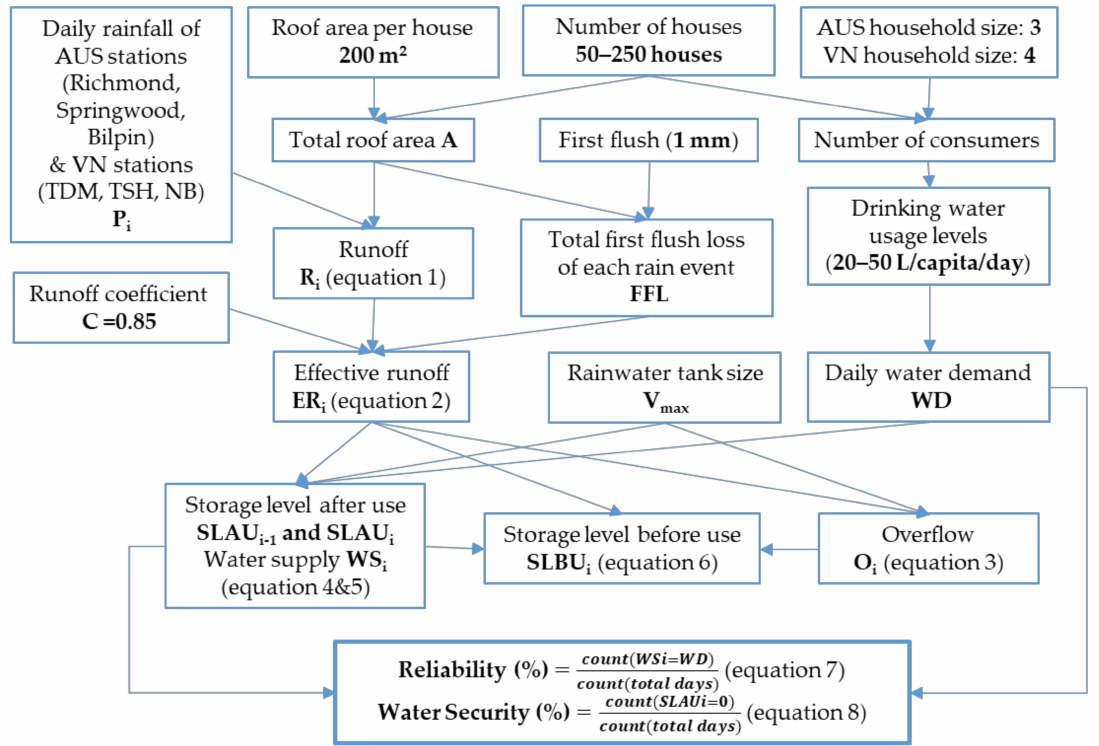
Figure 4. MATLAB modelling input and output parameters for reliability